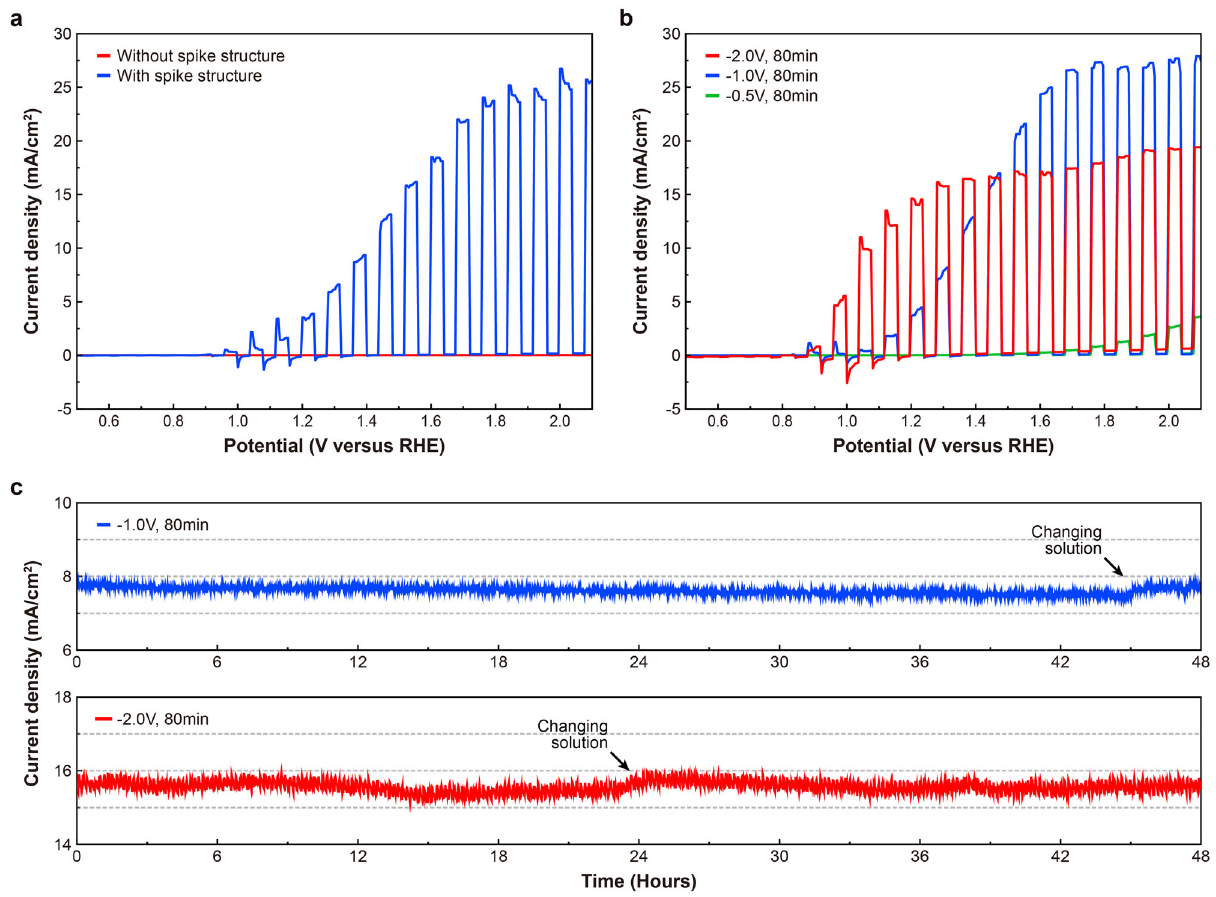
Fig. 4 PEC characterization for Ni/90 nm SiO 2 /n-Si photoanodes. a LSV curves obtained in 1 M KOH solution with chopped AM1.5G illumination for Ni/ 90 nm SiO 2 /n-Si photoanodes with (blue) and without (red) Al spiking included in the fabrication process. b LSV curves for spiked Ni/90 nm SiO 2 /n-Si photoanodes with Ni electrodeposited for 80 min at − 0.5, − 1.0, and − 2.0 V applied bias. c 48 h CA stability tests at − 1.3 V versus RHE in 1 M KOH solutions for spiked Ni/90 nm SiO 2 /Si photoanodes with Ni electrodeposited for 80 min at − 1.0 and − 2.0 V applied